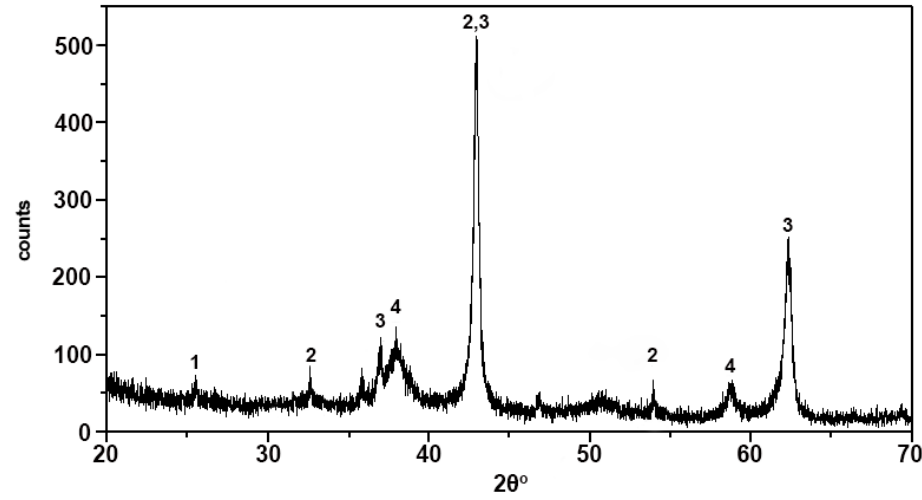
Figure 5. X-ray pattern of bulk mineral composition of final product. 1: Quartz, 2: magnesite, 3: periclase, 4: brucite.